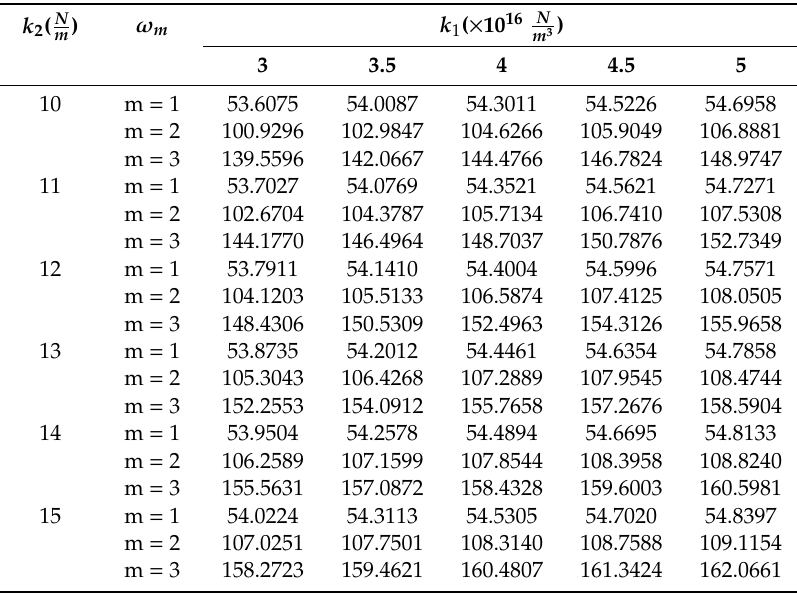
Table 6. Variation of the first three natural frequencies (GHz) with the elastic parameters of the Pasternak